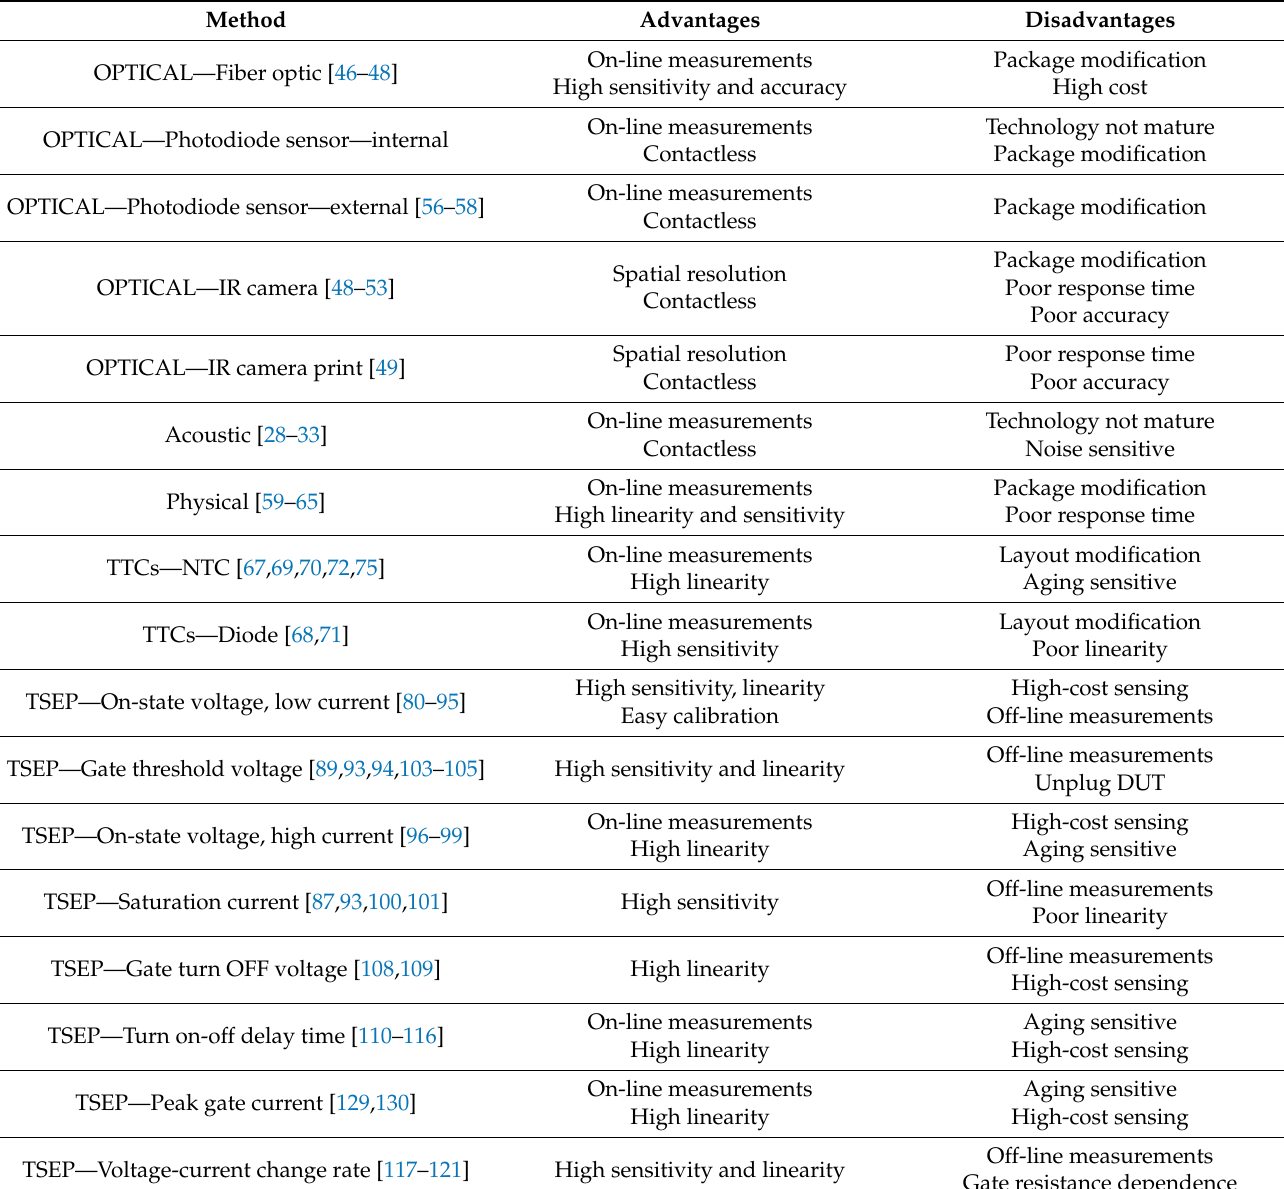
Table 2. Summary of different CM